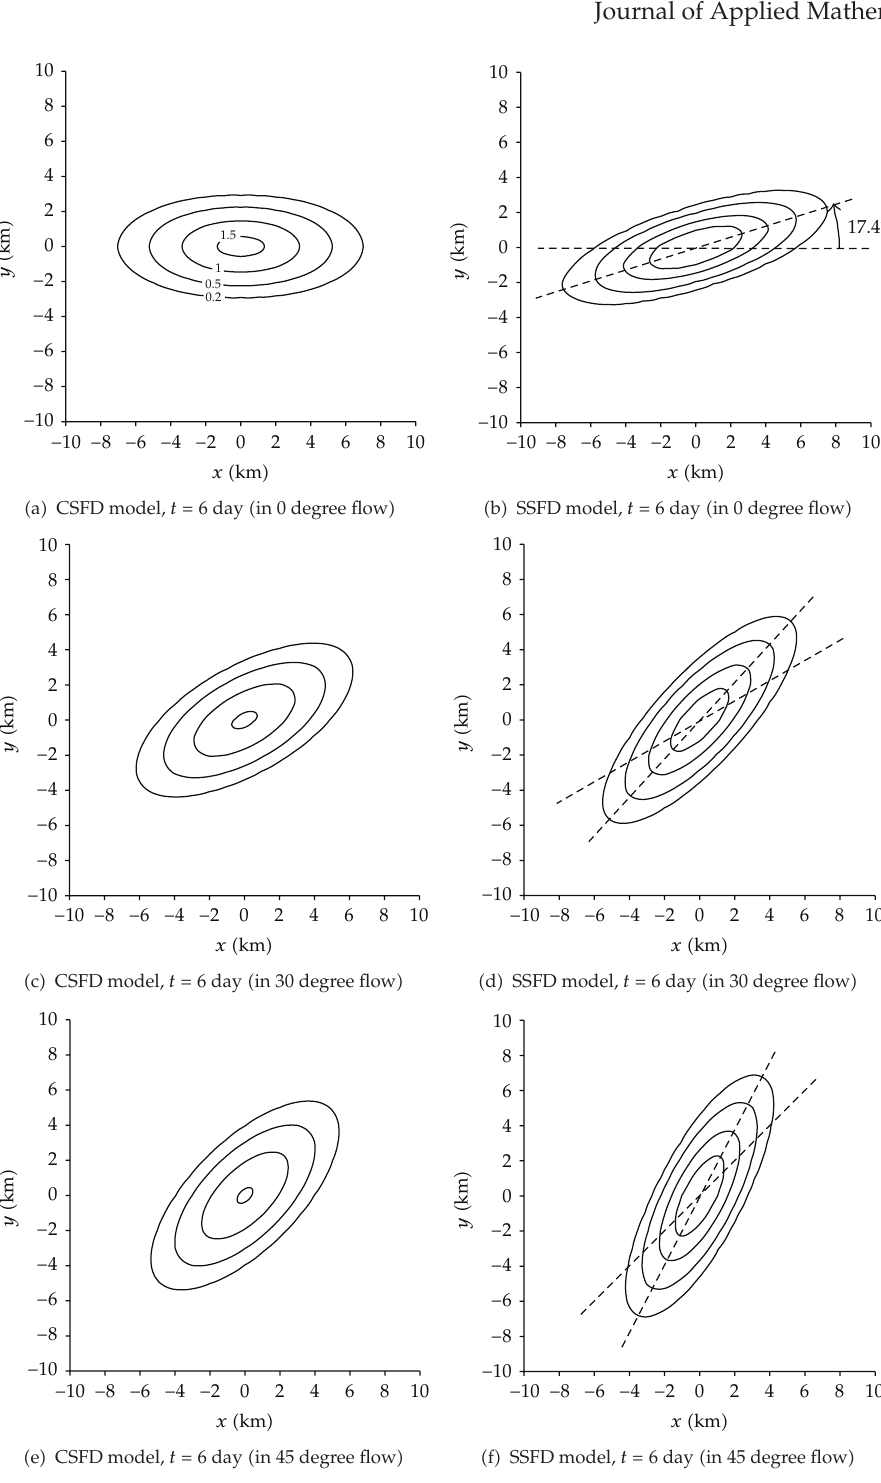
Figure 4: Concentration distribution in uniform oscillatory flow (cid:4) unit: ppm (cid:5)